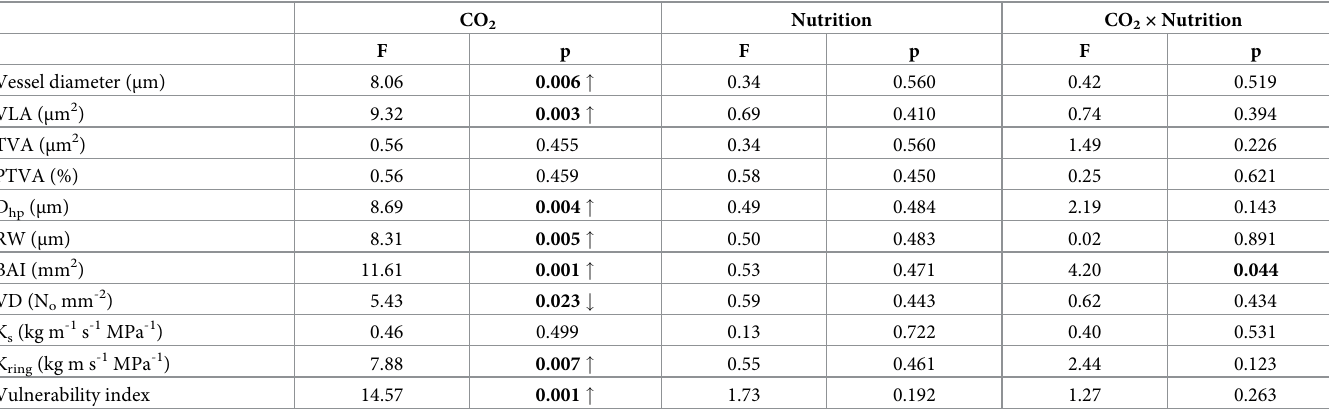
Table 2. Two-way analysis of variance (ANOVA) of the influence of CO 2 , nutrient supply, and their interactions on sessile oak saplings anatomical characteristics.